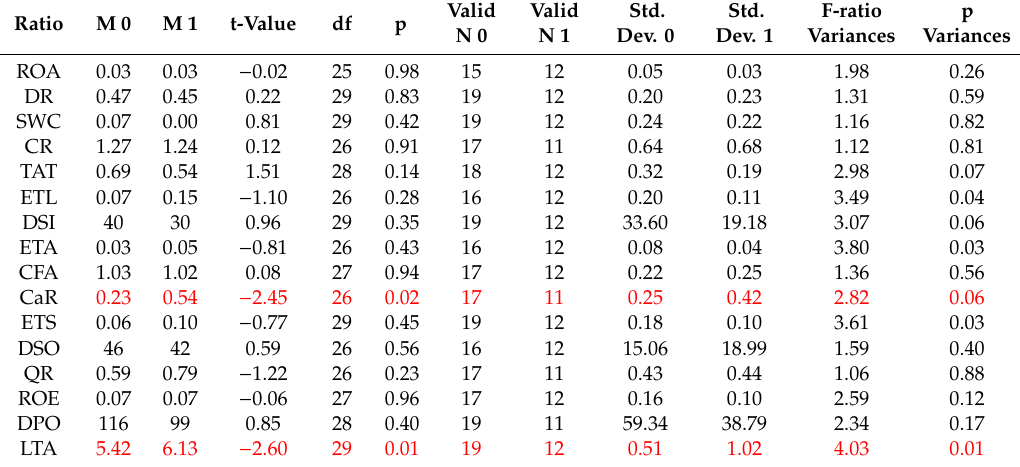
The red color means that di ff erences in the values of individual indicators are statistically